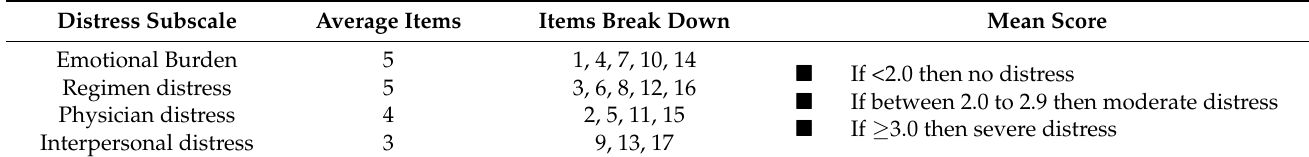
Table 2. Diabetes-specific distress subscale items